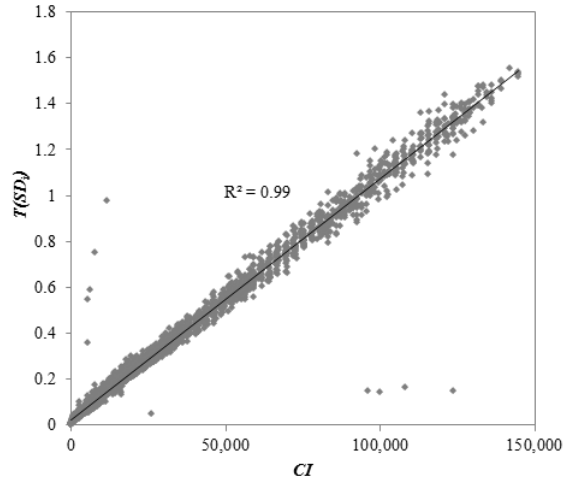
Figure 5: Quantification of computational intensity CI versus execution time T(SD i ) in seconds (for each subdomain).